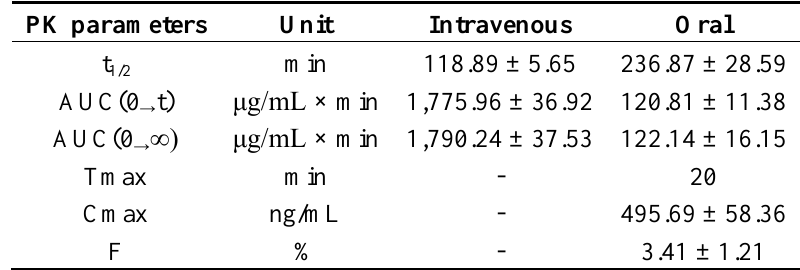
Table 5. Main pharmacokinetic parameters of QGR in rats determined after intravenous and oral administration ( n = 3, mean ± SD).